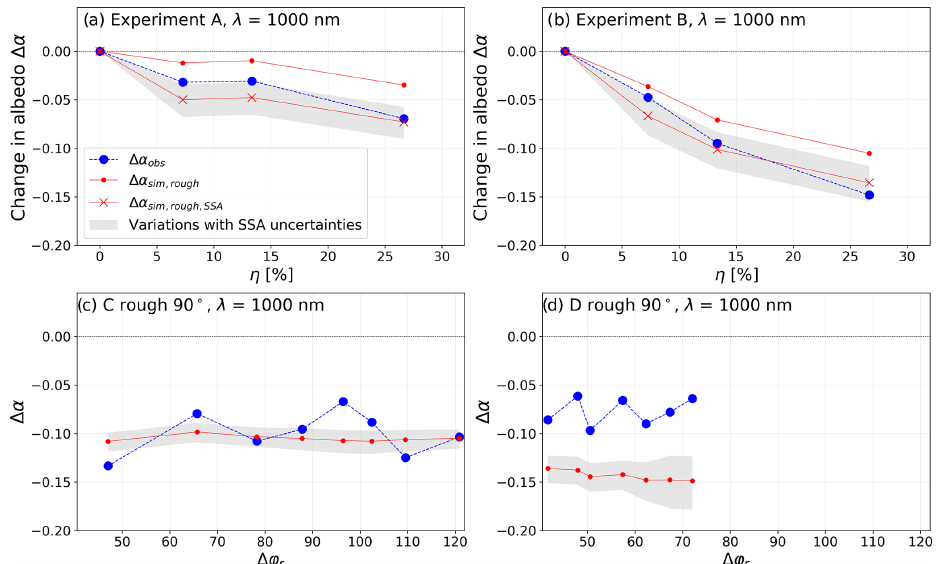
Figure 9. (a) and (b) are changes in albedo as a function of the η ratio at 1000nm for experiments A and B, respectively. Blue dashed lines are (cid:49)α obs ( α obs ( λ,θ s )– α obs ( λ,θ s , o )). Red dashed lines with points are (cid:49)α sim , rough ( α sim , rough ( λ,θ s )– α sim , smooth ( λ,θ s , o )) obtained using a constant SSA in RSRT (7.4m 2 kg − 1 for A and 4.5m 2 kg − 1 for B). Red lines with crosses are (cid:49)α sim , rough , ssa ( α sim , rough ( λ,θ s , SSA r )– α sim , smooth ( λ,θ s , o , SSA m )) obtained using SSA r for the smooth surface (at η = 0%, SSA r = 9.4m 2 kg − 1 for A and 5.3m 2 kg − 1 for B) and SSA m for rough surfaces ( η from 7% to 27%, SSA m = 7.4m 2 kg − 1 for A and 4.5m 2 kg − 1 for B). (c) and (d) are variations in (cid:49)α with (cid:49)ϕ r at 1000nm for experiments C and D, respectively (similar to Fig. 7e and f). (cid:49)α obs and (cid:49)α sim , rough are the observed and simulated albedo differences between the rough and the smooth surfaces at (cid:49)ϕ r . Grey shading represents the range of (cid:49)α obtained by varying the SSA by ± 10% in RSRT